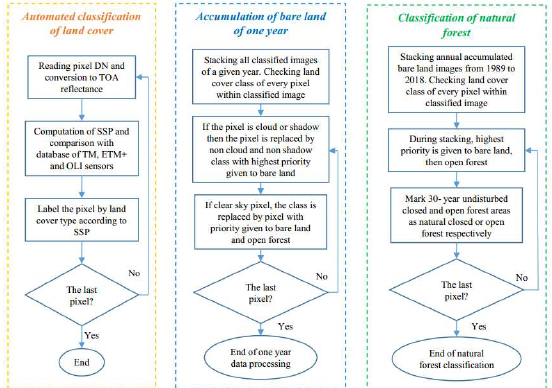
Figure 6. Flow chart of algorithm for automated classification of land cover and natural forest